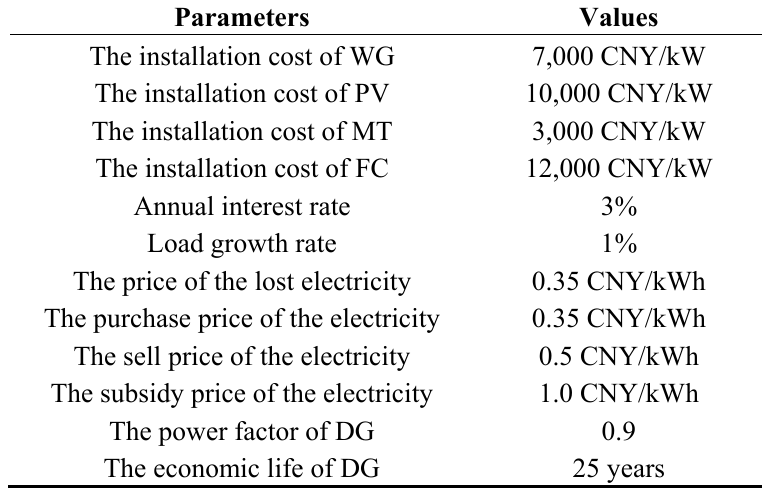
Table 2. Parameters and values in the example. WG, wind power generation; PV, photovoltaic power generation; MT, micro gas turbine; FC, fuel